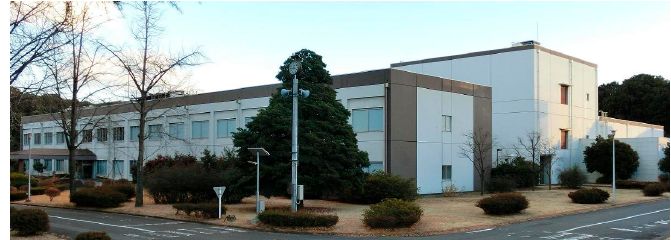
Figure 1. A picture of the ion beam research building of Takasaki Ion Accelerators for Advanced Radiation Application (TIARA).